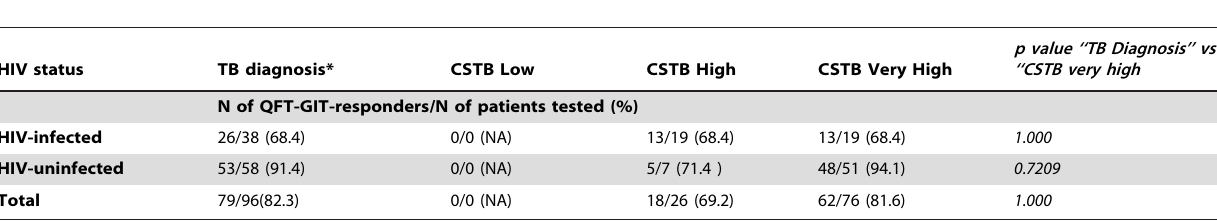
Table 7. Influence of the physicians’ clinical suspicion of tuberculosis (CSTB) on rate of QFT-GIT results in active pulmonary TB patients according to their disease localisation and HIV